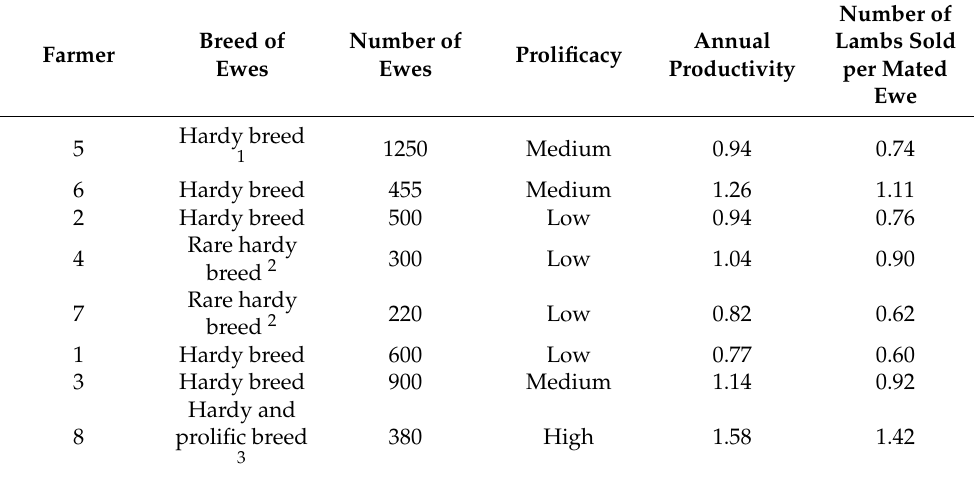
Table 1. Characteristics of the eight sheep meat farmers monitored in this study: flock and zootechni- cal